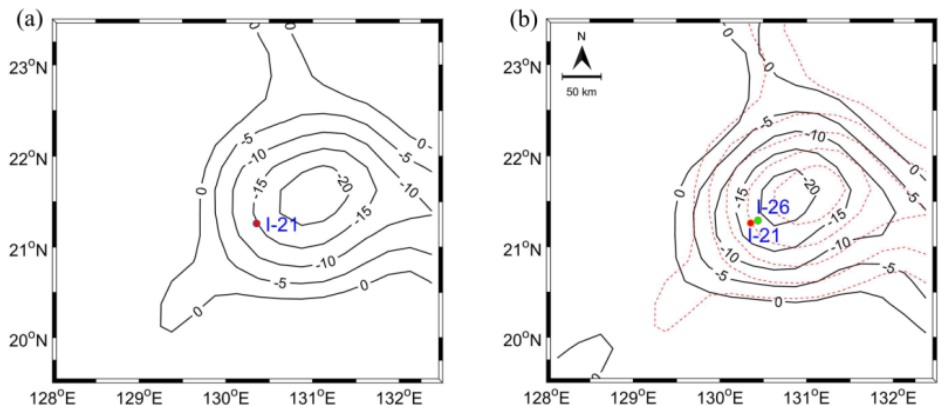
Figure 13. Contours (black solid lines) of negative SSHA (cm) on 21 July ( a ) and 26 July ( b ), respectively. The red and green dots marked with “I-21” and “I-26” denote the locations of Argo float on 21 and 26 July, respectively. Overlaid in ( b ) are contours of negative SSHA on 21 July (red dashed lines), implying the movement of the eddy.